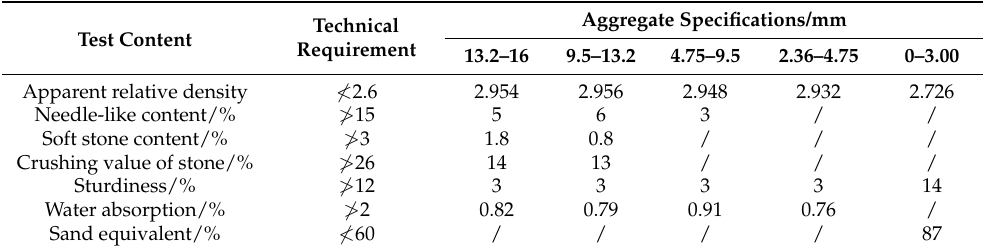
Table 2. Technical index value of